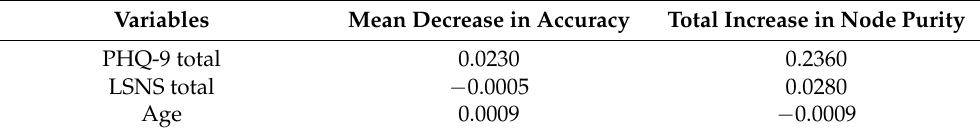
Table 4. Variable Importance in random forest